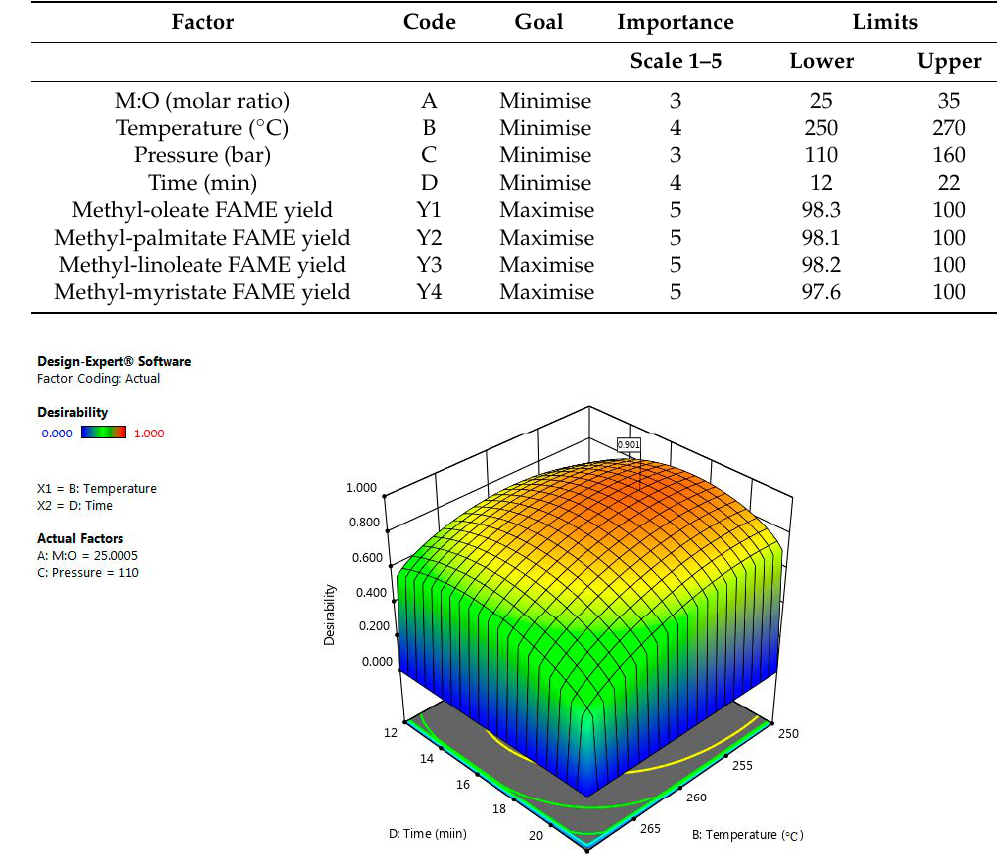
Figure 5. Response surface of the effect of M:O molar ratio and reaction temperature on the yield of methyl-oleate.